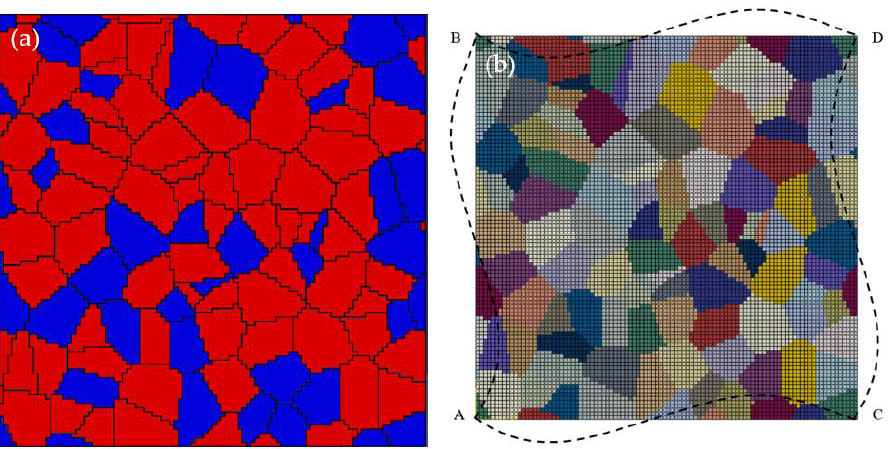
Figure 6. ( a ) RVE with O phase (red) and β phase (blue); and ( b ) periodic boundary conditions.